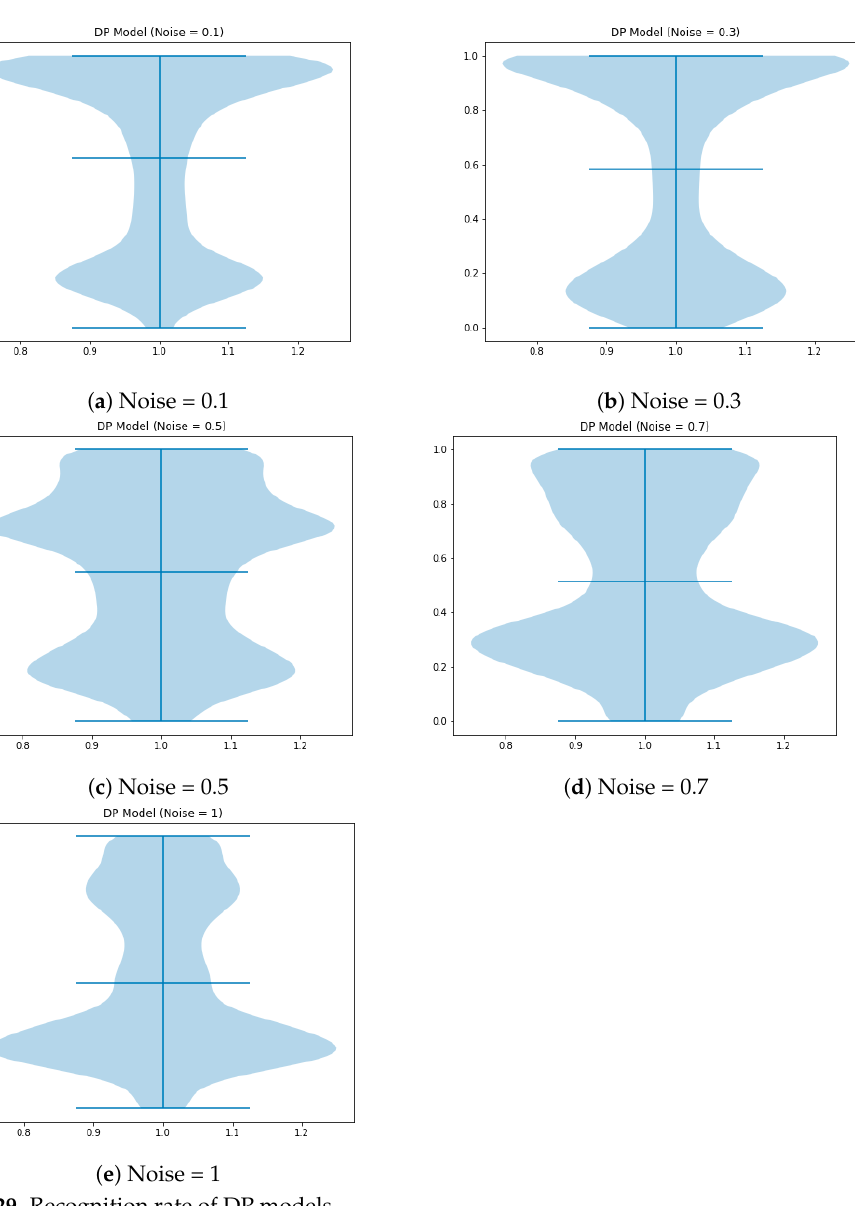
Figure 28. Recognition rate of the baseline model.